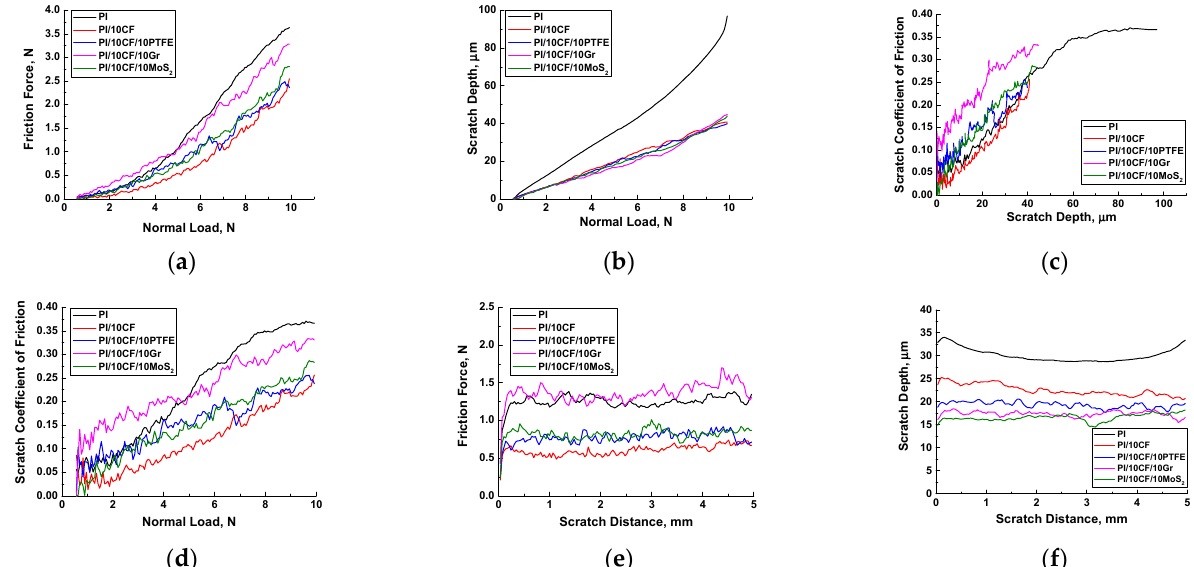
Figure 15. The scratch test results for the CCF-reinforced PI-based composites: increasing ( a – d ) and constant ( e , f ) loads.